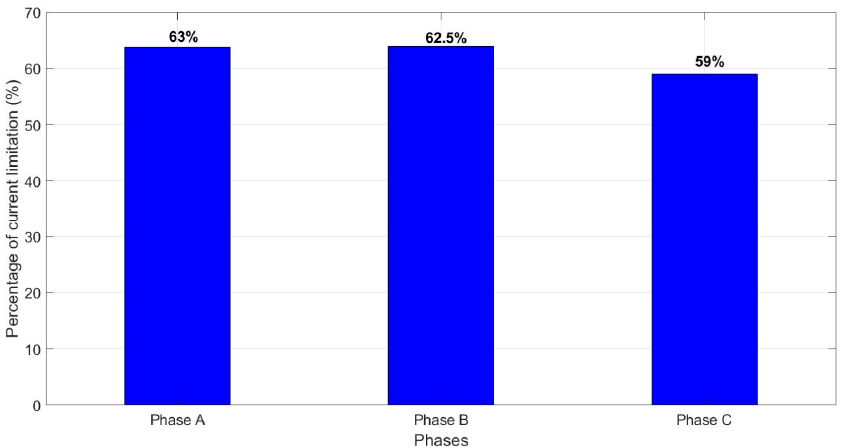
Figure 14. Current limitation percentage (%) of the SCs for phases A, B, and C compared to a conventional copper cable during a 3-Phase-to-ground fault at 50% of cable’s length.